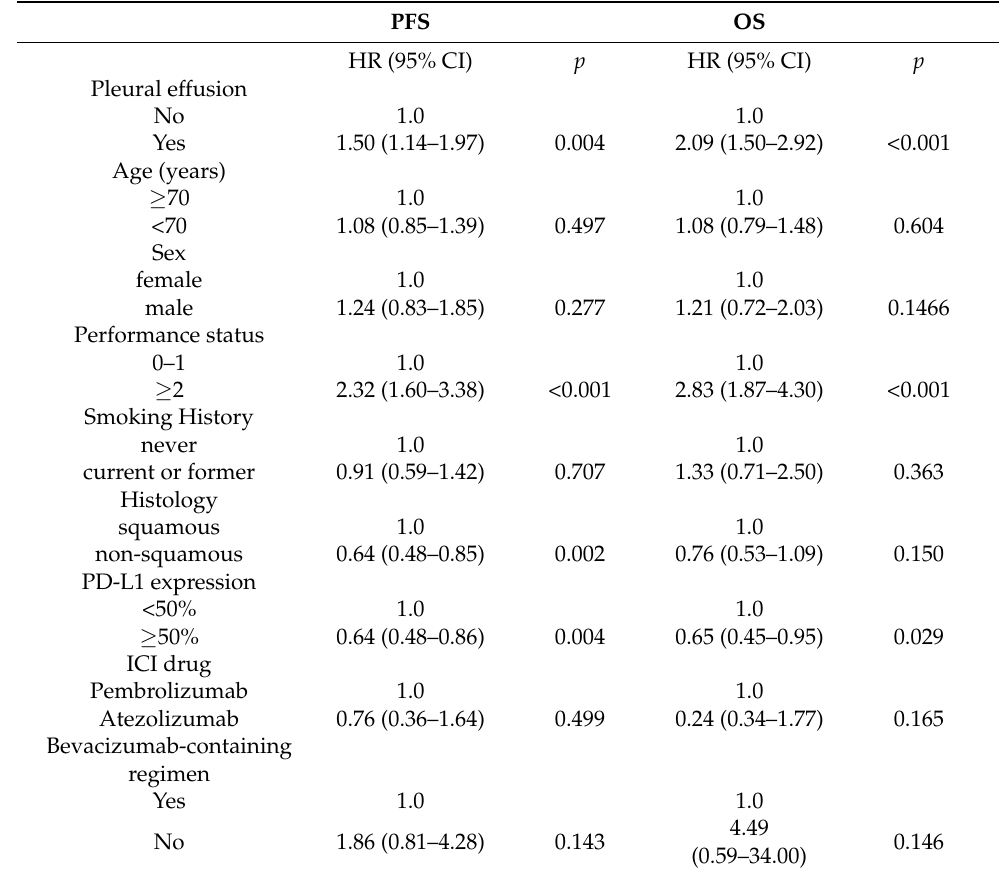
Table 3. Multivariate analysis of factors associated with progression-free survival and overall